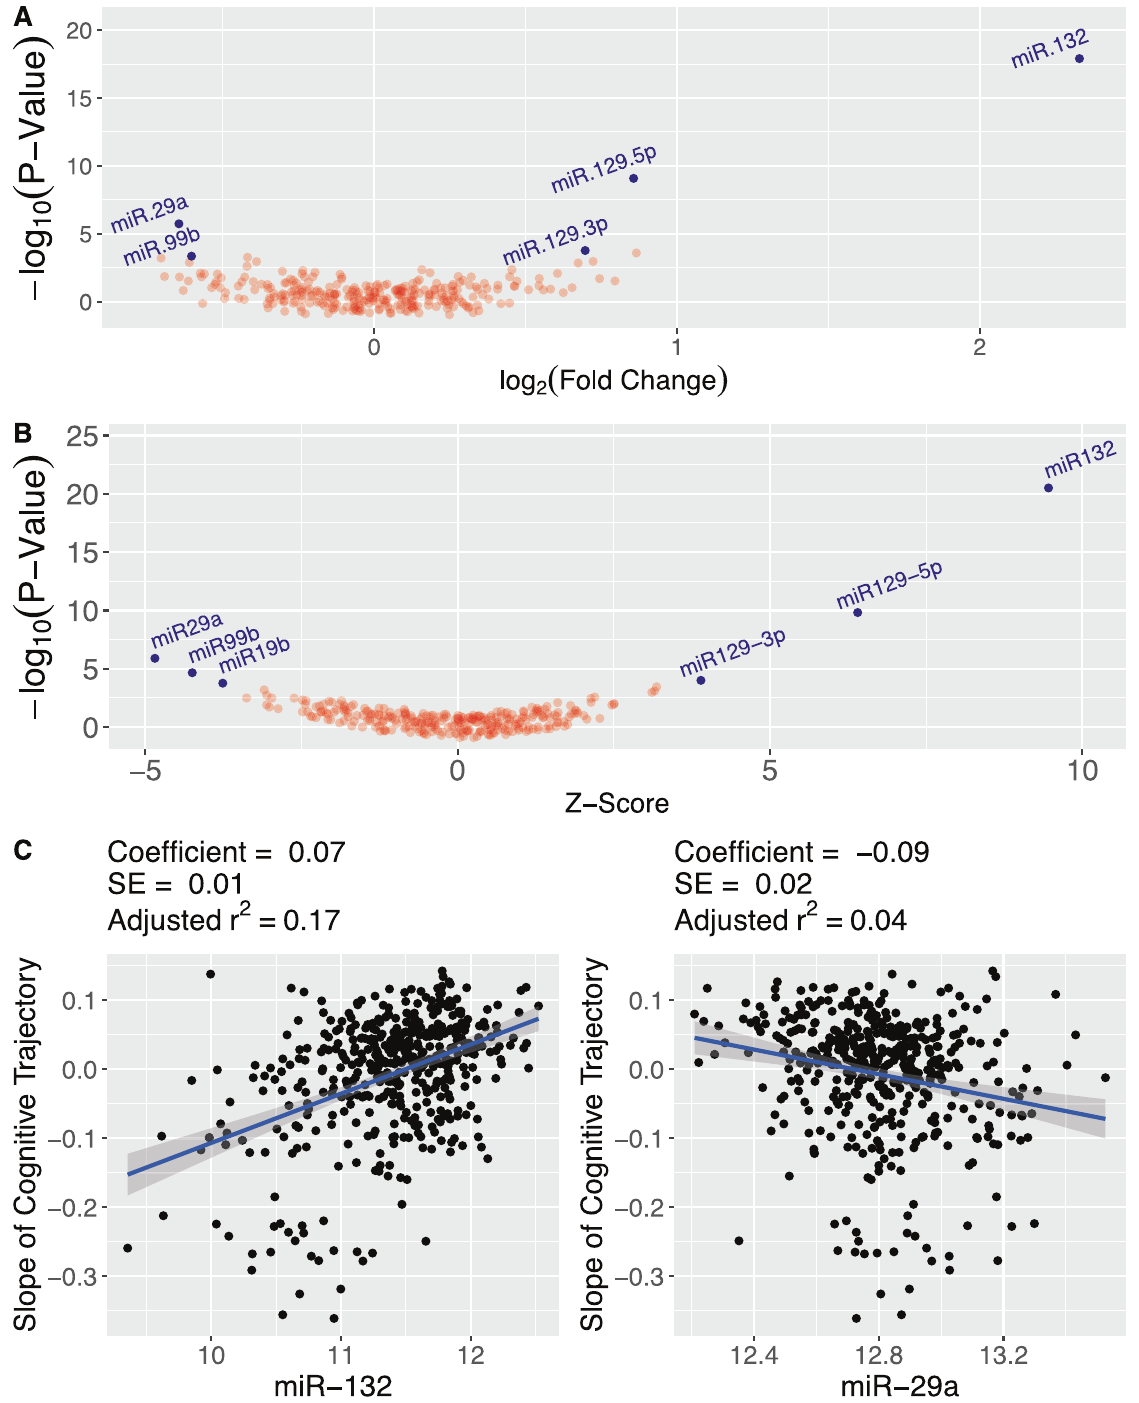
Fig. 2 Global miRNA association study of cognitive trajectory in ROS/MAP. A Volcano plot of the global miRNA association study of cognitive trajectory in the discovery dataset. The miRNAs colored in blue are those associated with cognitive trajectory at adjusted p < 0.05. B Volcano plot for the meta-analysis of the global miRNA association studies of cognitive trajectory in the discovery and replication datasets. C Plot of slope of cognitive trajectory versus individual miR-132 and miR-29a expression in the discovery dataset. Note that the more positive the slope, the more stable the trajectory, and the more negative the slope, the faster the